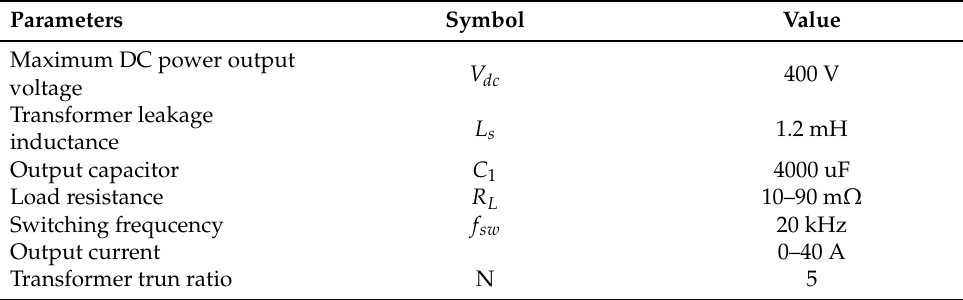
Figure 6. Off-gird microgrid system: ( a ) wind–solar microgrid system; ( b ) battery-SC hybrid energy storage system; and ( c ) control system. Table 2. Configuration specification of DC